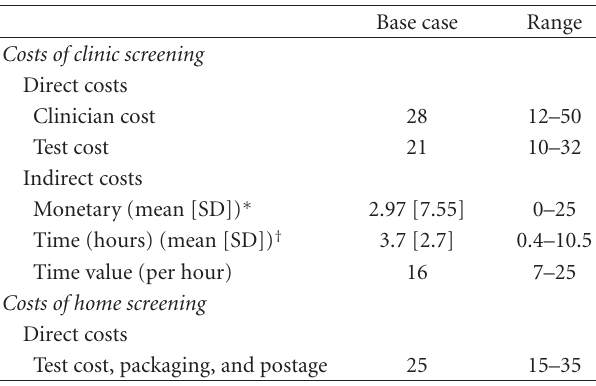
Table 2: Direct and indirect costs per screening test received and ranges examined in sensitivity analyses.